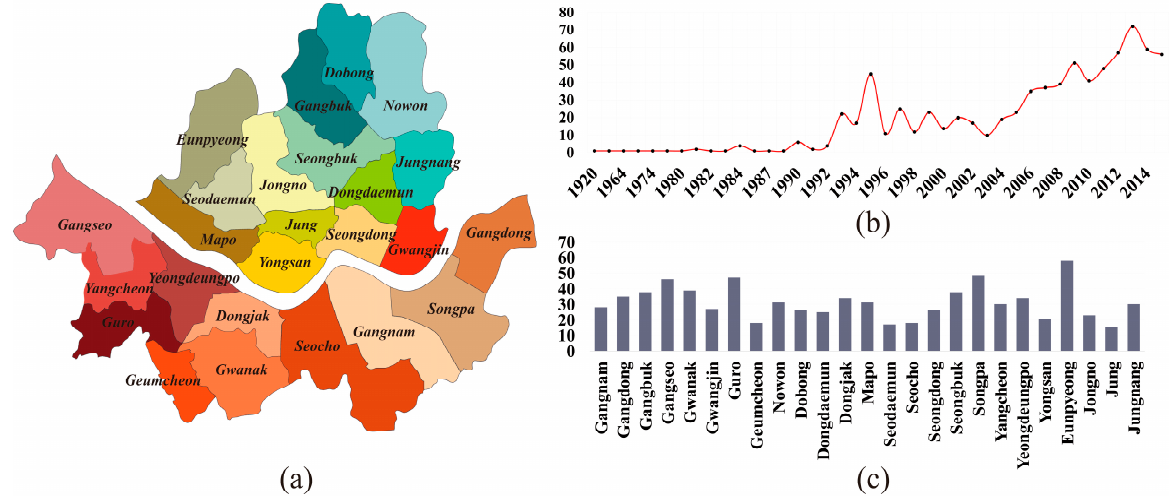
Figure 6. The current status of public libraries in Seoul: ( a ) administrative districts in Seoul; ( b ) trends in public library growth by year; ( c ) distribution of public libraries by administrative district.